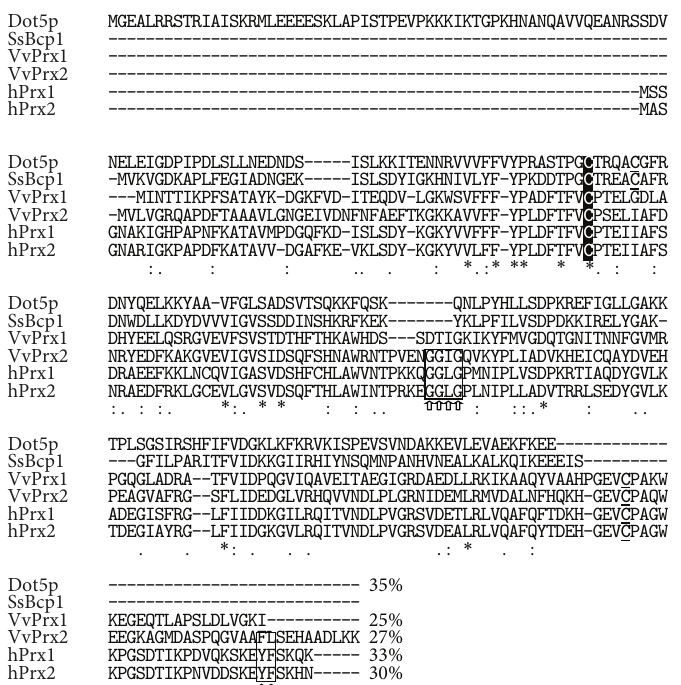
Figure 1: Alignment of Ss Bcp1 with the Prx orthologues. The multiple sequence alignment of S. solfataricus Bcp1 (AAK42253), H. sapiens h Prx1 (BAG70076) and h Prx2 (AAH39428), S. cerevisiae Dot5p (DAA08535), and V. vulnificus Vv Prx1 (ADV88988) and Vv Prx2 (ADV87477) was performed using the MUSCLE algorithm. Identical and similar amino acids are marked with asterisks and points, respectively. The peroxidatic cysteines are indicated in white and the resolving cysteines are underlined; the motifs for the sensitive Prxs are boxed and marked with arrows.